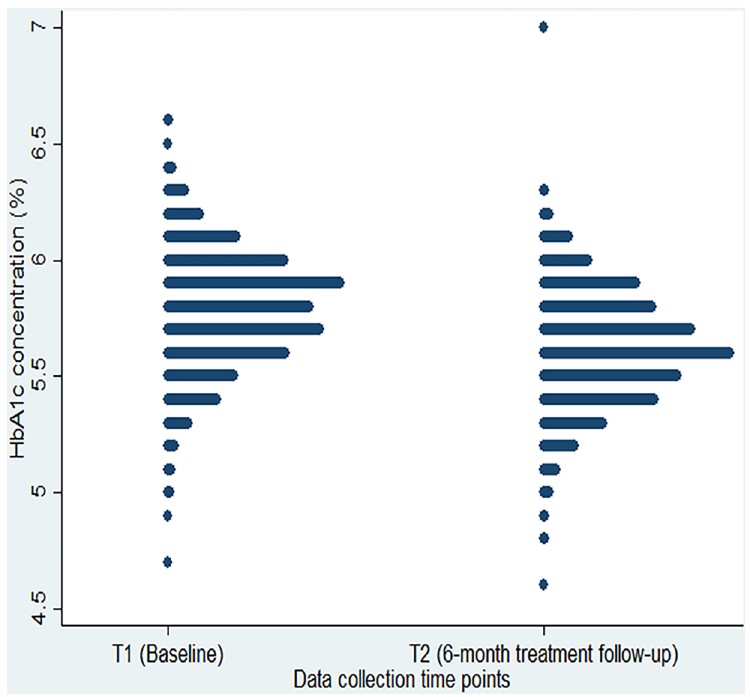
Fig 2. Distribution of HbA1c measured at baseline and 6 month follow-up in the total study sample, irrespective of the intervention obtained(N = 842).